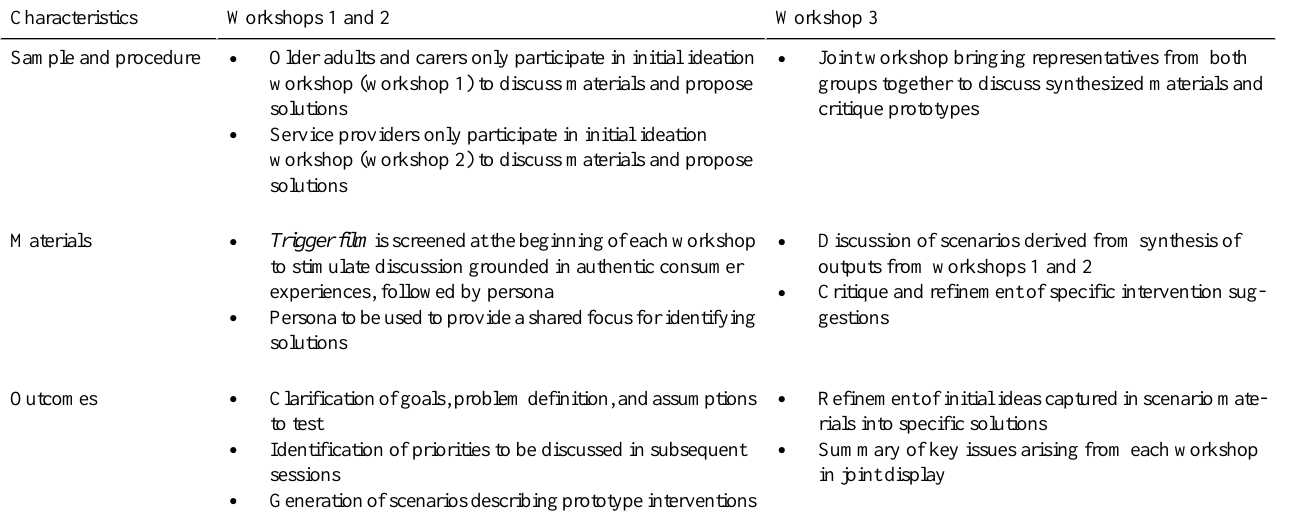
Table 1. A summary of the co-design workshop procedure and